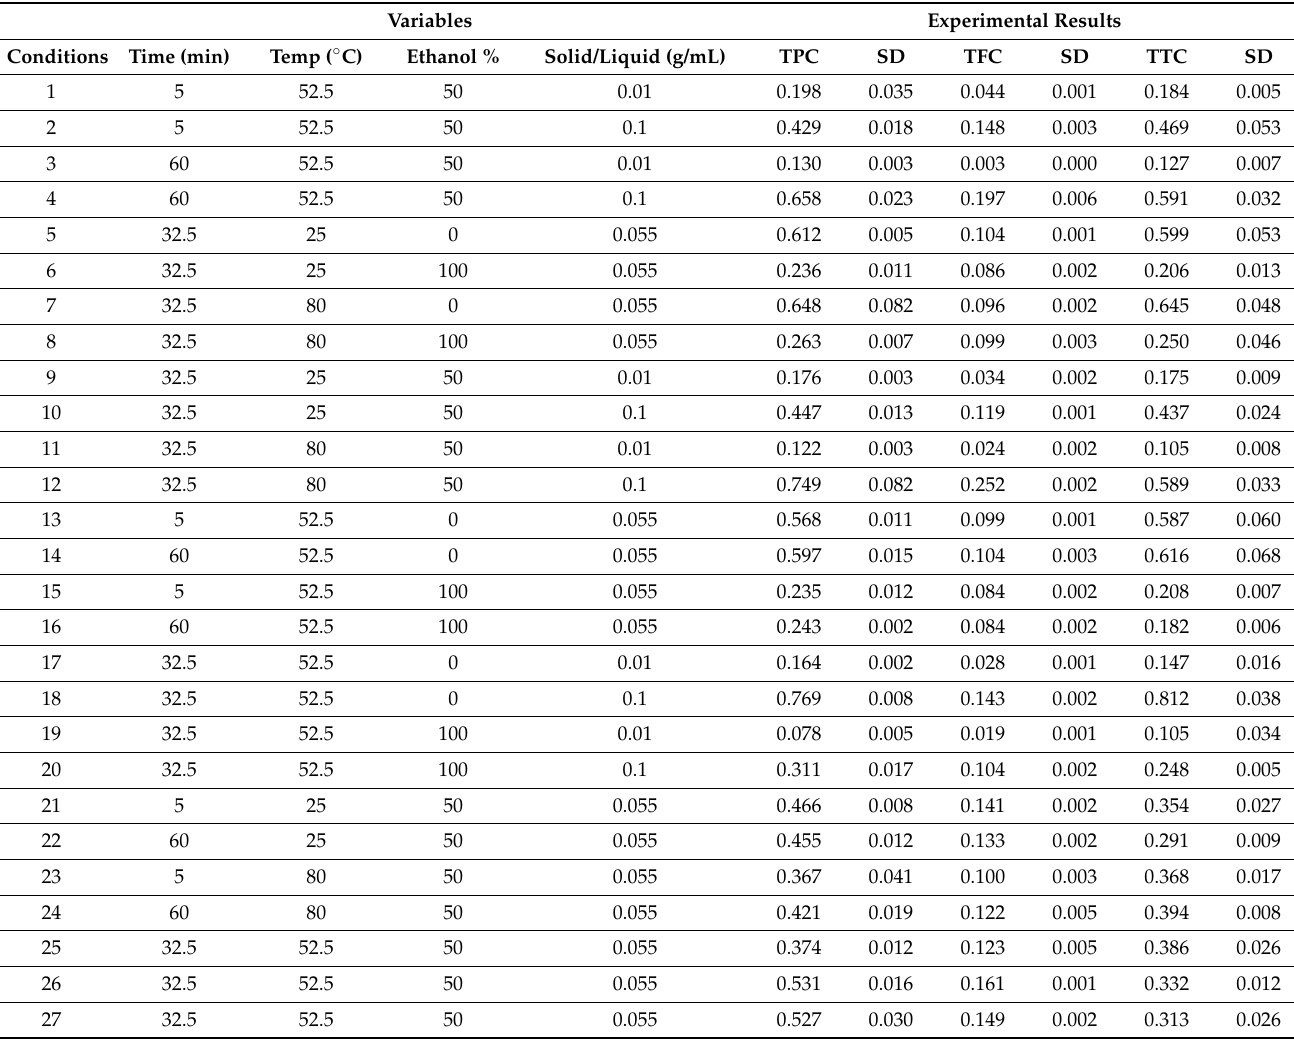
Table 5. Experimental design matrix with coded variables and experimental data for total polyphenols, total flavonoids, and total tannins. Variables Experimental